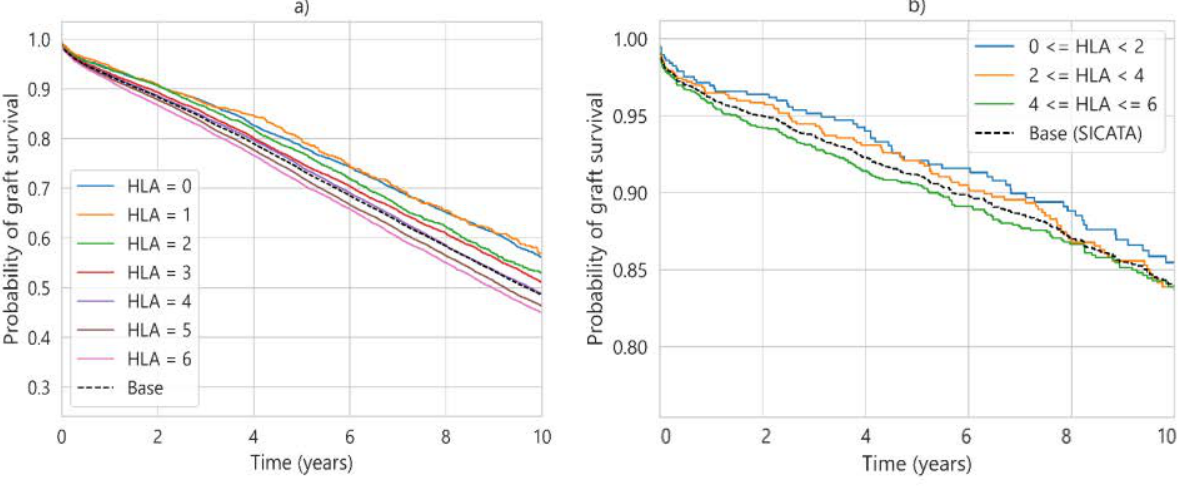
Figure 6. Ten-year survival probability considering different aHLA values, where ( a ) UNOS ( p < 0.005) and ( b ) SICATA ( p > 0.1).